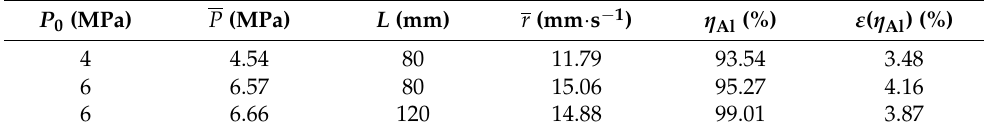
Figure 9. Particle Size Distributions of CCPs. Table 5. Combustion Efficiencies of Al.